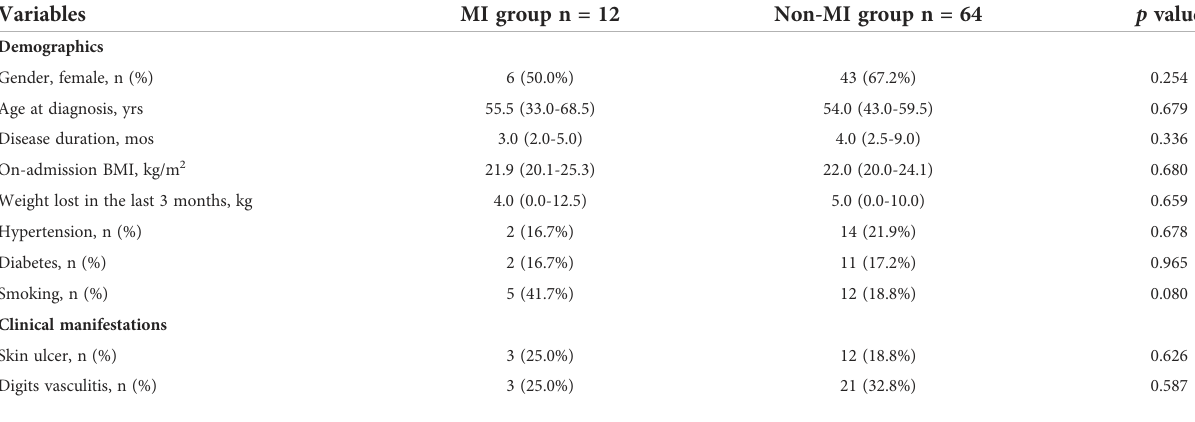
TABLE 3 Comparison of characteristics between patients with and without myocardial